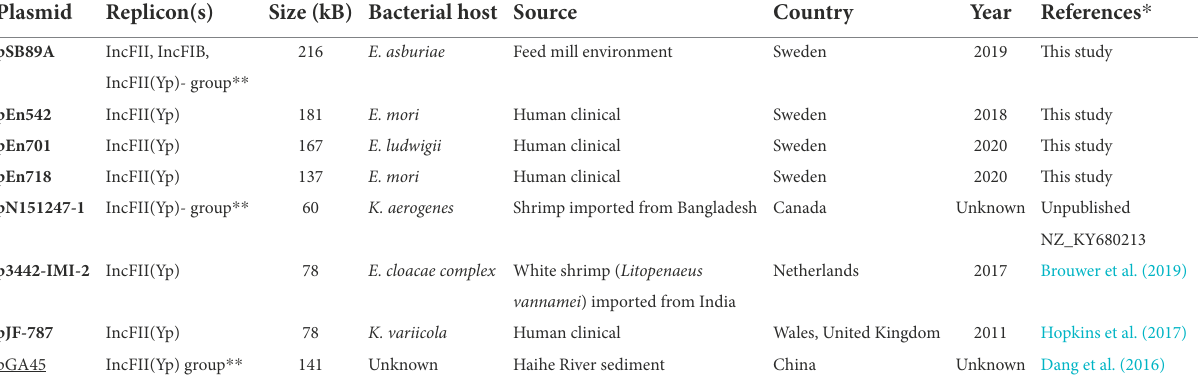
TABLE 4 Overview on plasmids sequenced in the current study and previously published plasmids containing bla IMI-2 (bold) and bla IMI-3 (underlined).